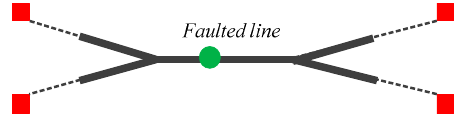
Figure 7. Fault line selection with fewer observers.